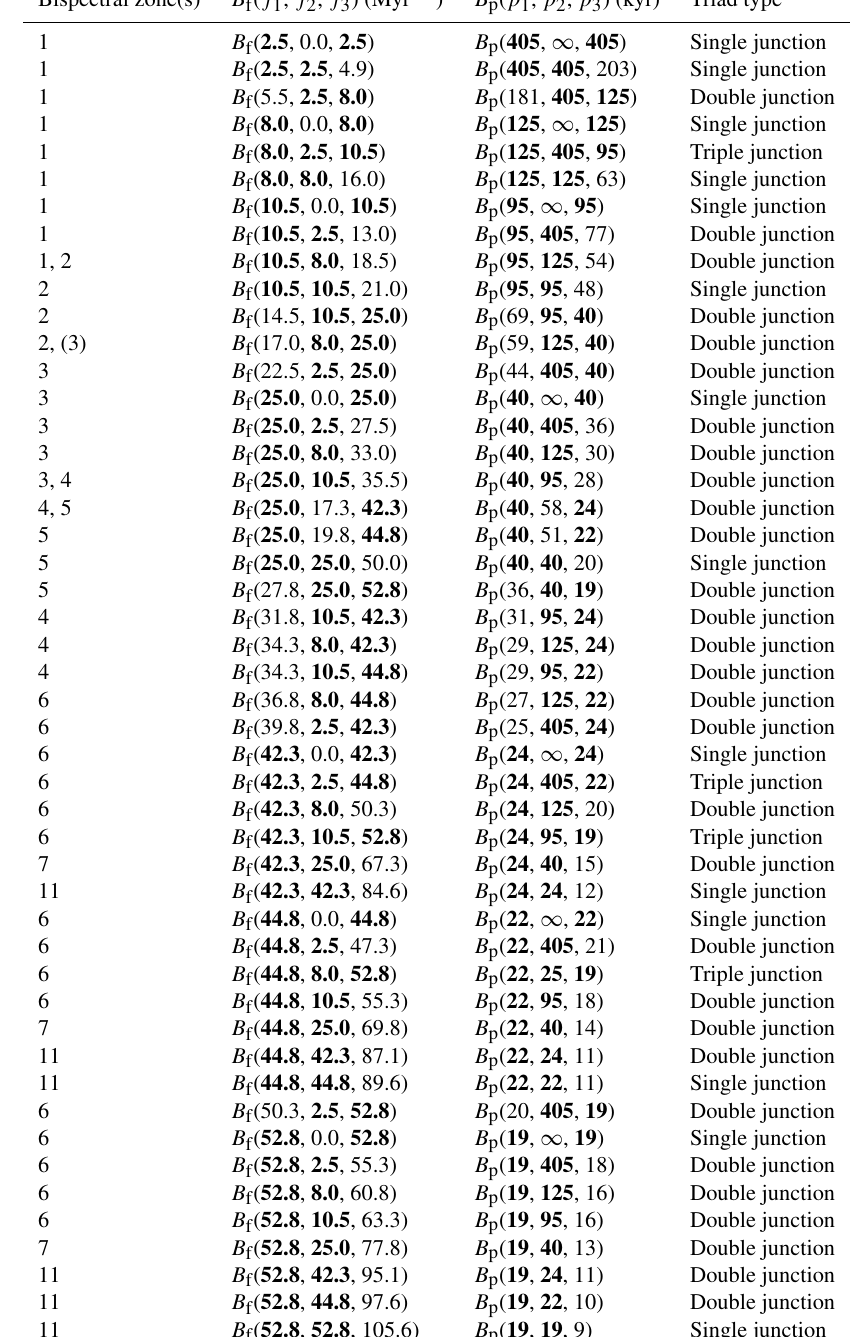
Table A2. Bispectral triads among climate cycles with astronomical frequencies. One, two, or three astronomical frequencies (bold font) can partake in triad interactions, and we refer to these coordinates in the bispectrum as single, double, or triple junctions, respectively. These triads reflect positions in the frequency–frequency domain where nonlinear energy transfers among astronomically paced climate cycles are likely to occur. They correspond to the crossing points of the coloured lines in Fig. 3. In the case of a “single junction”, an astronomically paced cycle exchanges energy with itself or with a frequency that is only slightly offset. Single junctions where f 1 = f 2 constitute the first higher harmonic interactions. Double or triple junctions are “combination tones” of two or three different astronomically paced cycles (Pestiaux et al., 1988; Hagelberg et al., 1991; King, 1996; Rial and Anaclerio,